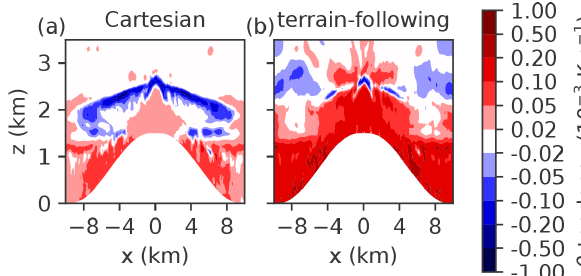
Figure 3. Cross sections of total θ tendency for the averaging period between 3.5 and 4h after initialization for the Cartesian (left-hand side of Eq. 10) and the terrain-following coordinate system (left- hand side of Eq. 6), both divided by (cid:104) z η ρ (cid:105) . ponents of the total θ tendency (resolved + subgrid-scale) in Fig. 4 are both very close for the two calculation